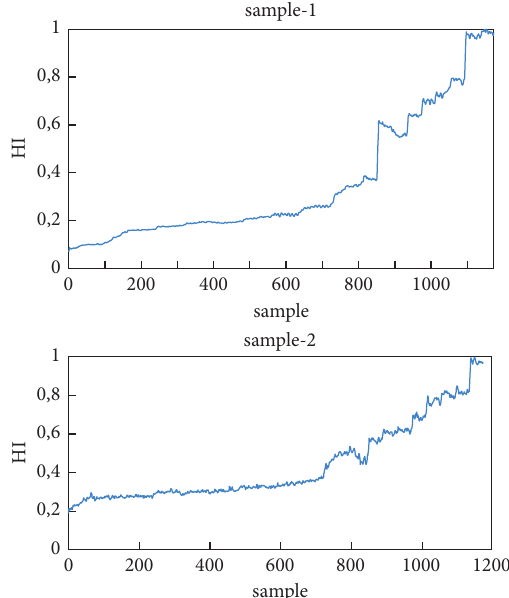
Figure 7: Trend index of two data samples are defined as 664 and 667, and ten samples are added in each training. The results are shown in Figure 9.